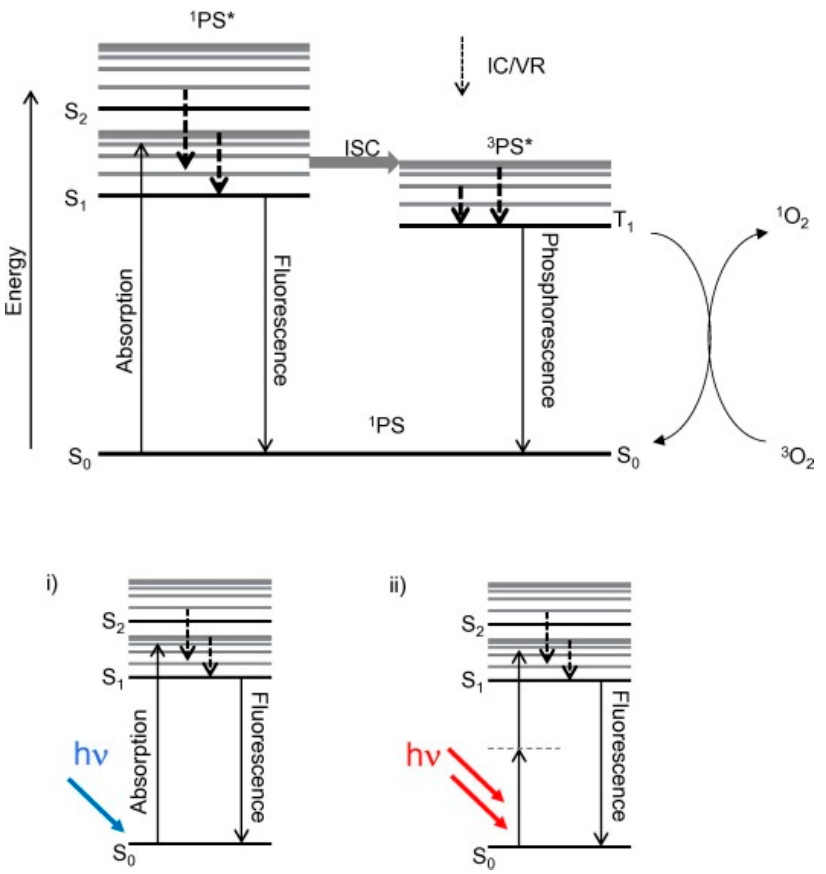
Figure 2. A simplified Jablonski diagram showing typical energy levels and transitions relevant to the formation of the triplet state of the photosensitizer and photosensitization of molecular oxygen. IC = internal conversion, VR = vibrational relaxation, ISC = intersystem crossing. Reproduced from McKenzie et al. [32], with permission from Elsevier.